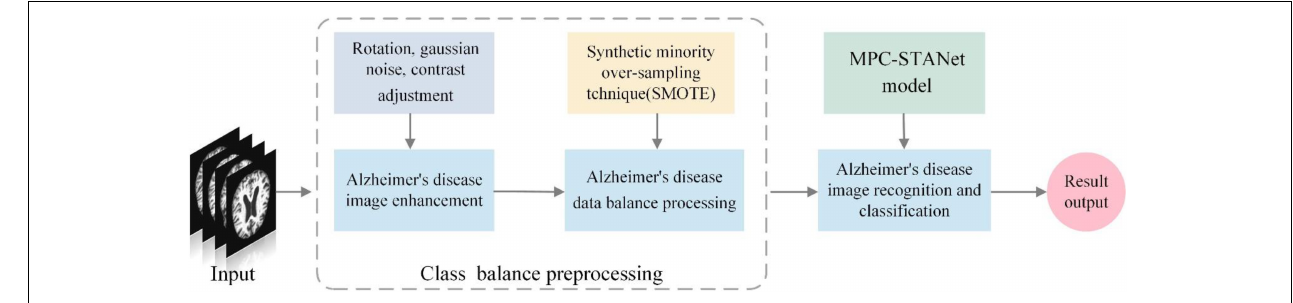
FIGURE 3 | Principles of Alzheimer’s disease recognition.